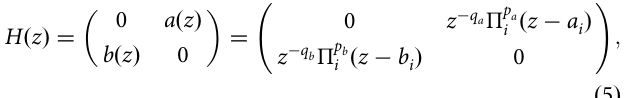
Table 1 Illustration to the phase diagram of the tight-binding model. The parameter space ( t 0 , t 1 , γ 0 ) is classi fi ed into phase I-IV according to the distinct locations and centers of the exceptional ring (ER) in the momentum space ( k x , k y ). Phase I and phase II both possess a single exceptional ring, but encircle ( π , π ) and (0, 0) respectively. Phase III and phase IV both possess two exceptional rings, where the former encircle ( π , π ) and (0, 0), while the latter encircle ( π , π ) and ( π , π ). Phase Parameters Location of ER Center of